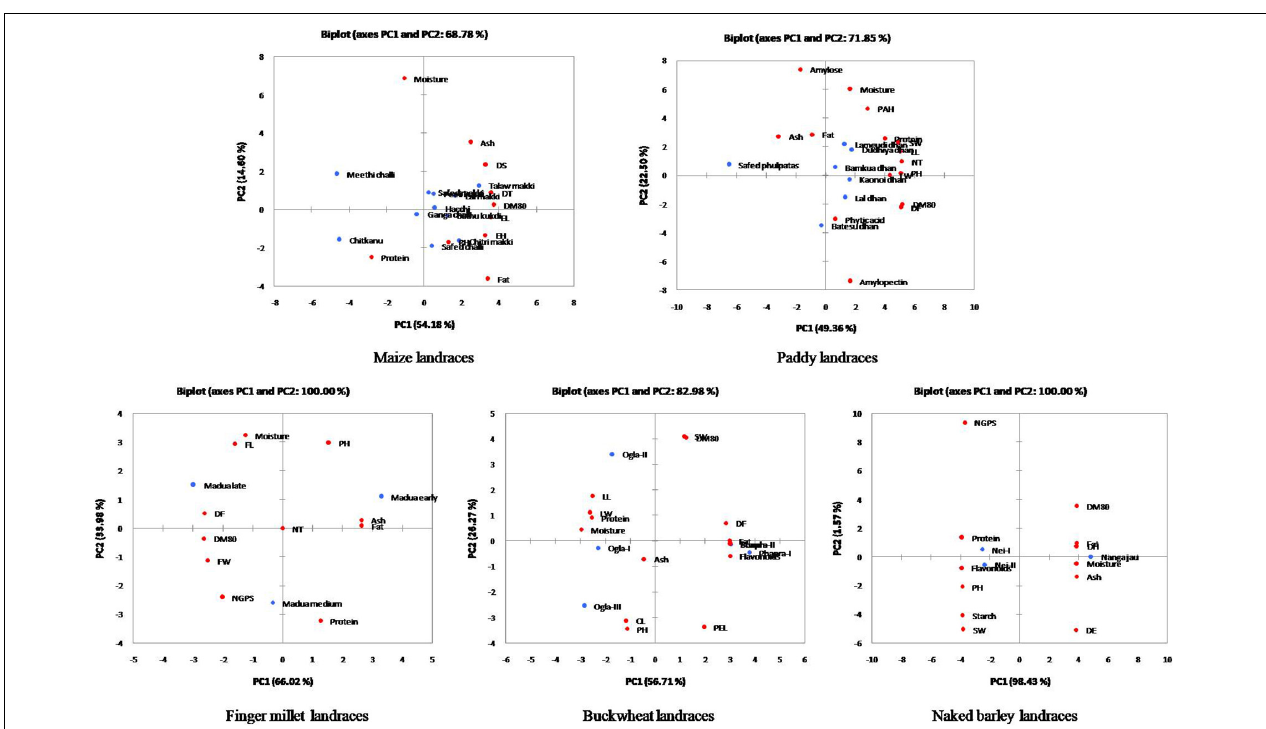
FIGURE 3 | Principal component analysis (PCA) plots of agro-morphological characteristics and nutritional attributes for traditional crop landraces along with the projection of bi-plot scores.